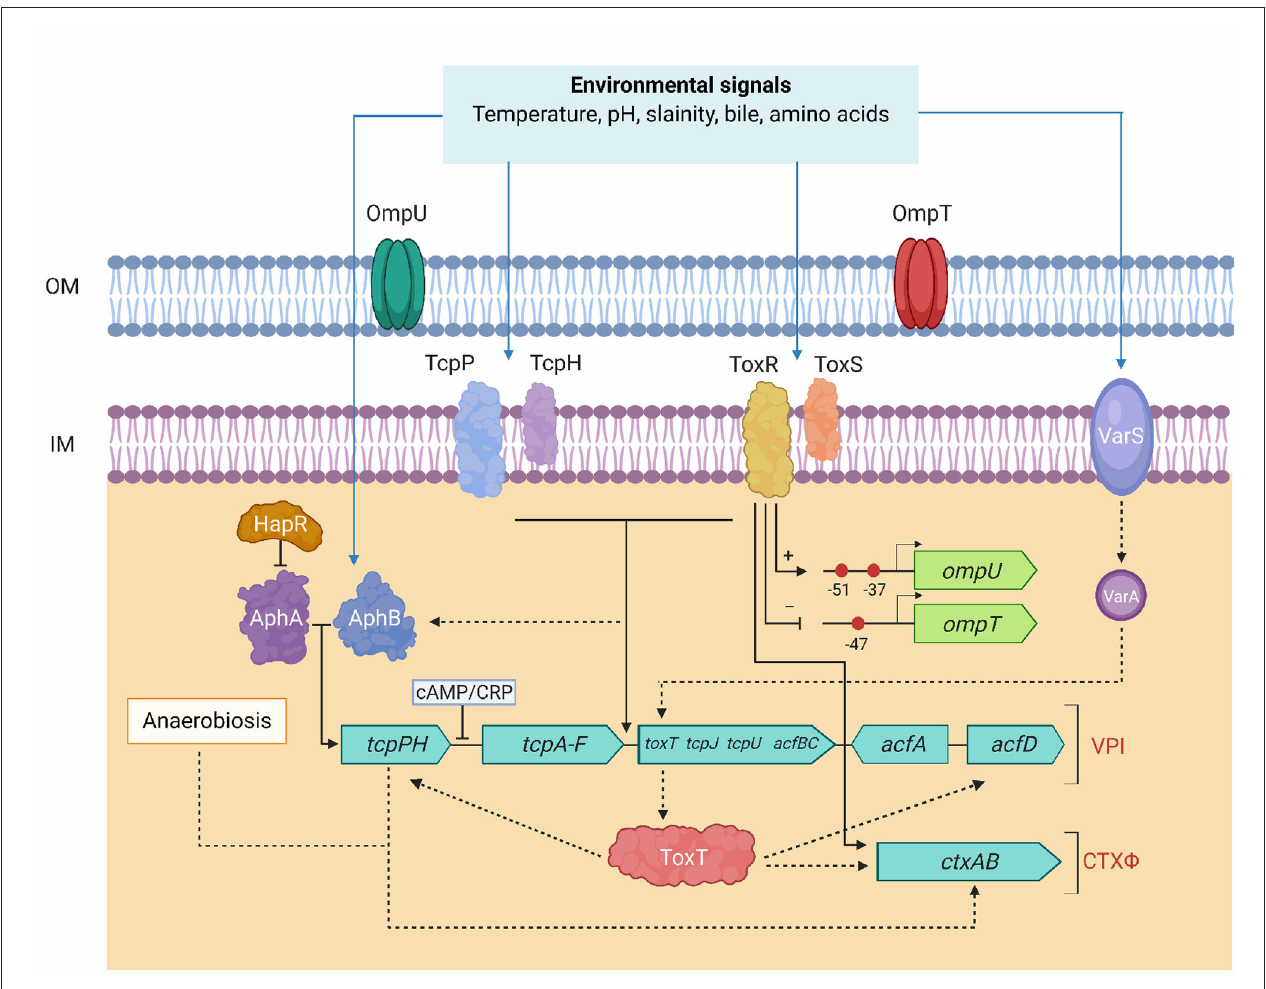
FIGURE 4 | Regulation model of Tox-mediated virulence genes in V. chlerae . TcpP/TcpH and ToxR/ToxS function together in activating transcription of toxT . ToxR and TcpP need accessory proteins (ToxS and TcpH, respectively) for maximal activity. ToxT initiates transcription of the full tcp operon, ctxAB , and acf . AphA and AphB activate transcription of the tcpPH operon in response to environmental conditions. tcpPH promoter is negatively influenced by the global regulator, CRP. ToxR/ToxS, and AphA/AphB also regulate genes other than ctx and acf . ToxRS, AphAB, TcpPH, and ToxT coordinately regulate the transcription of ctx and tcp . AphA and AphB activates expression of the tcpPH. TcpPH and ToxRS regulate ctx and tcp genes through ToxT. AphB has been linked to the expression of tcpPH for anaerobiosis that enhances the production of CT. The direct activator and the second activator are differentiated by black solid and dotted arrows, respectively. Blue arrows indicate different environmental conditions sensed by the ToxRS and TcpPH, AphAB, and VarS regulatory systems. The two-component VarS-VarA system responds to environmental factors and signals toxT. ToxR, independently activates and represses transcription of ompU and ompT . ToxR modulation was shown by an